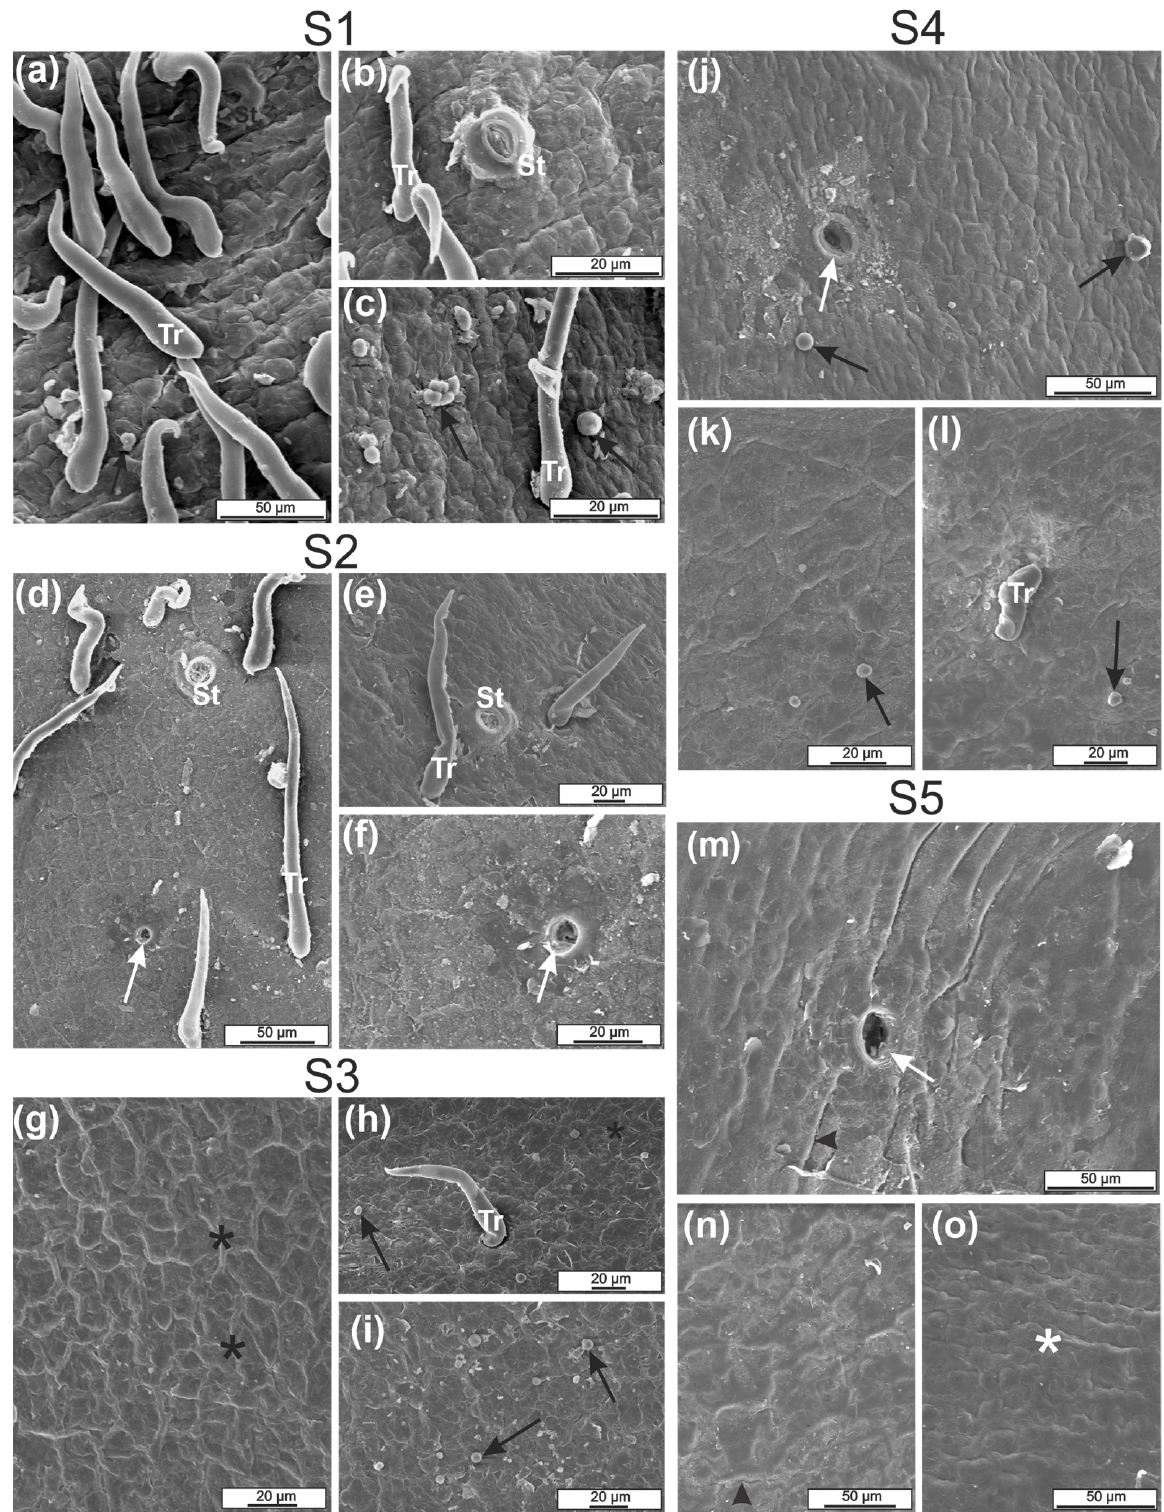
Figure 5. Scanning electron micrographs of the cuticle of CCP 76 cashew pseudofruits in five stages (S1, S2, S3, S4, and S5). S1 ( a – c ), S2 ( d – f ), S3 ( g – i ), S4 ( j – l ), and S5 ( m – o ). Globular wax (black arrows), epicuticular wax ornamentation (* black), altered epicuticular wax ornamentation (* white), superficial microcracks (arrowheads), and trichome scars (white arrows). St = stomata, Tr =